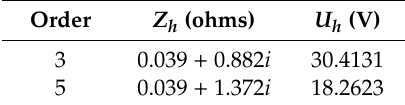
Table 6. The harmonic power-flow calculation results.